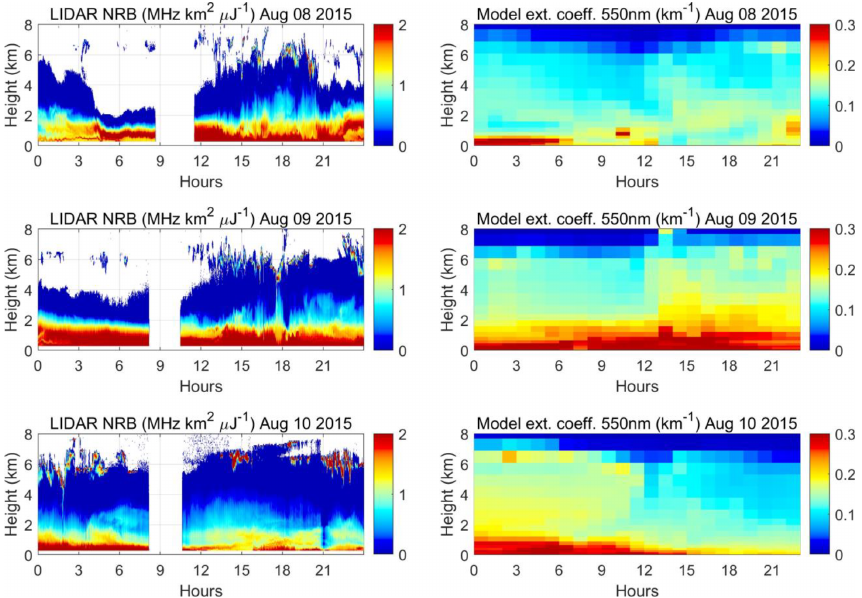
Figure 9. Natural logarithm of normalized relative backscatter (NRB) at 532nm measured at the KAUST–MPLNET station (left column) and the model-simulated dust extinction coefficient at 550nm (right column) during the dust event of 8/9 August. Times are reported in